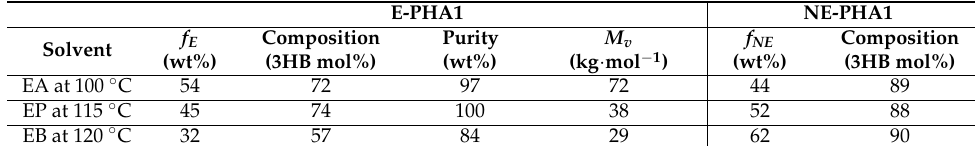
Table 2. Characterization of the extracted (E-PHA1) and of the non-extracted PHA (NE-PHA1) from Biomass1 with the three EEs.